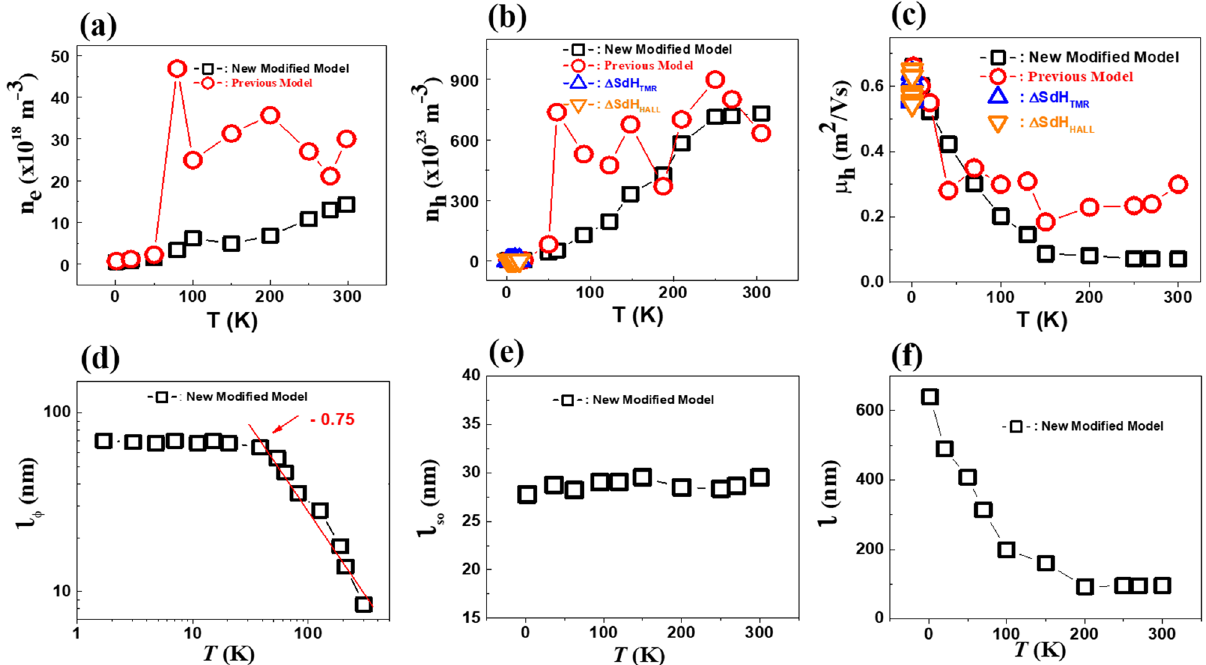
Figure 4. ( a ) The electron density n e ( b ) the hole density n h and ( c ) the hole mobility µ h as a function of temperatures obtained from the analysis of the new modified two-band model, previous model, and Shubnikov-de Haas (SdH) oscillations. ( d ) the phase coherence length l (cid:31) , ( e ) the spin–orbit scattering length l SO , and ( f ) the mean free path l of the electron carriers as a function of temperatures estimated from the analysis based on the new modified two-band